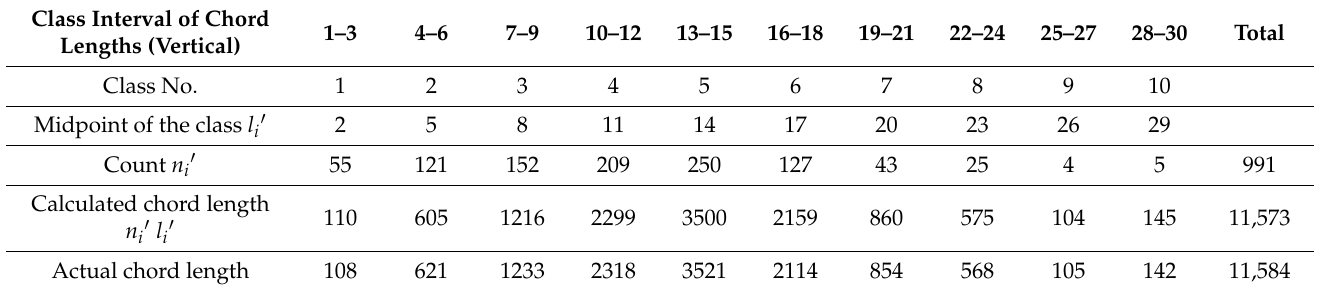
Table 1. A set of chords obtained by vertical secant object scanning (1024 pixels) in projection image. Class Interval of Chord Lengths (Vertical) Class